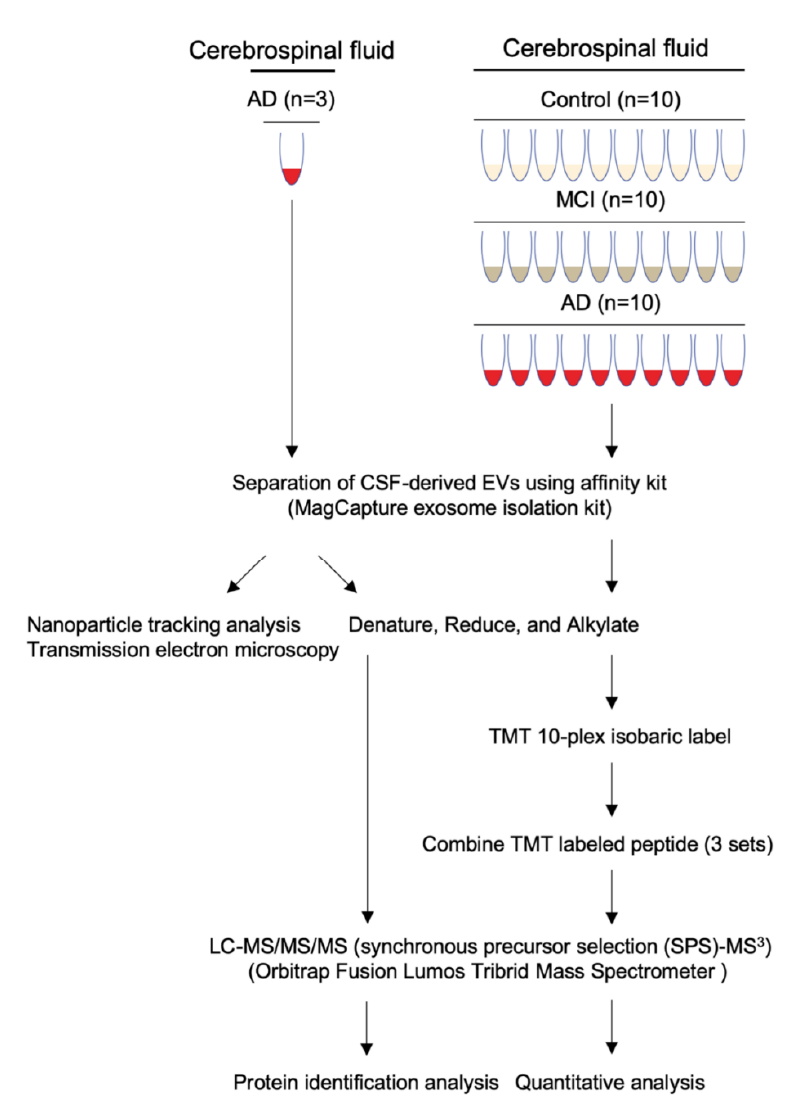
Figure 1. Workflow used in proteomics analysis of CSF-derived EVs: EVs were separated from control, MCI, and AD CSF using the Affinity Capture method (MagCapture Exosome Isolation kit). The separated EVs were denatured, reduced and alkylated, followed by Lys-C and trypsin digestion, and labeled with a TMT 10-plex isobaric label kit for quantitative proteomics analysis. The non-labeled peptide ( left ) and combined TMT-labeled peptide ( right ) were analyzed by MS 3 on an Orbitrap Fusion Lumos Tribrid Mass Spectrometer.